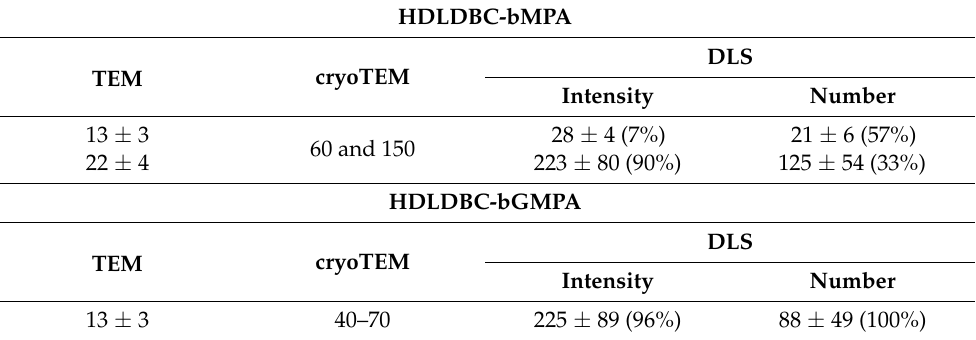
Table 1. TEM, cryoTEM and DLS size data in nm measured for HDLDBC-bMPA and HDLDBC- bGMPA.